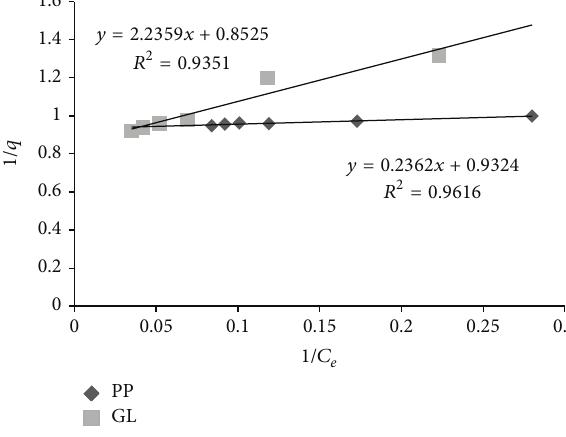
Figure 12: Comparative study of effect of time on percentage removal of BG.